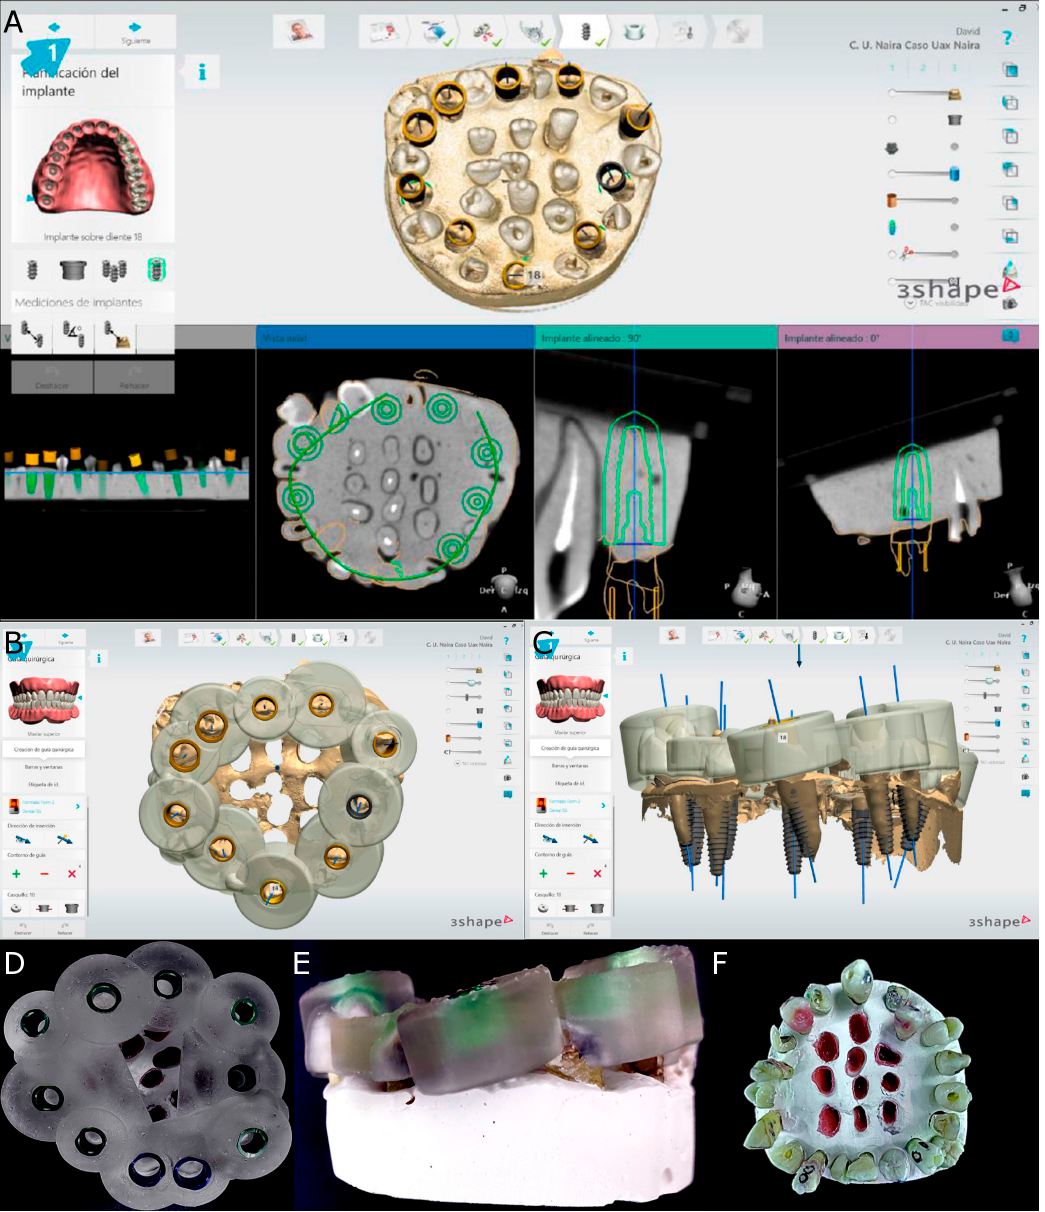
Figure 4. ( A ) Drilling site planning in the CBCT scan, ( B ) occlusal view of the surgical template design for computer-aided static navigation technique, ( C ) lateral view of the drilling bur selection according to the root dimensions, ( D ) occlusal and ( E ) lateral view of the surgical template manufactured and ( F ) occlusal view of the transplanted